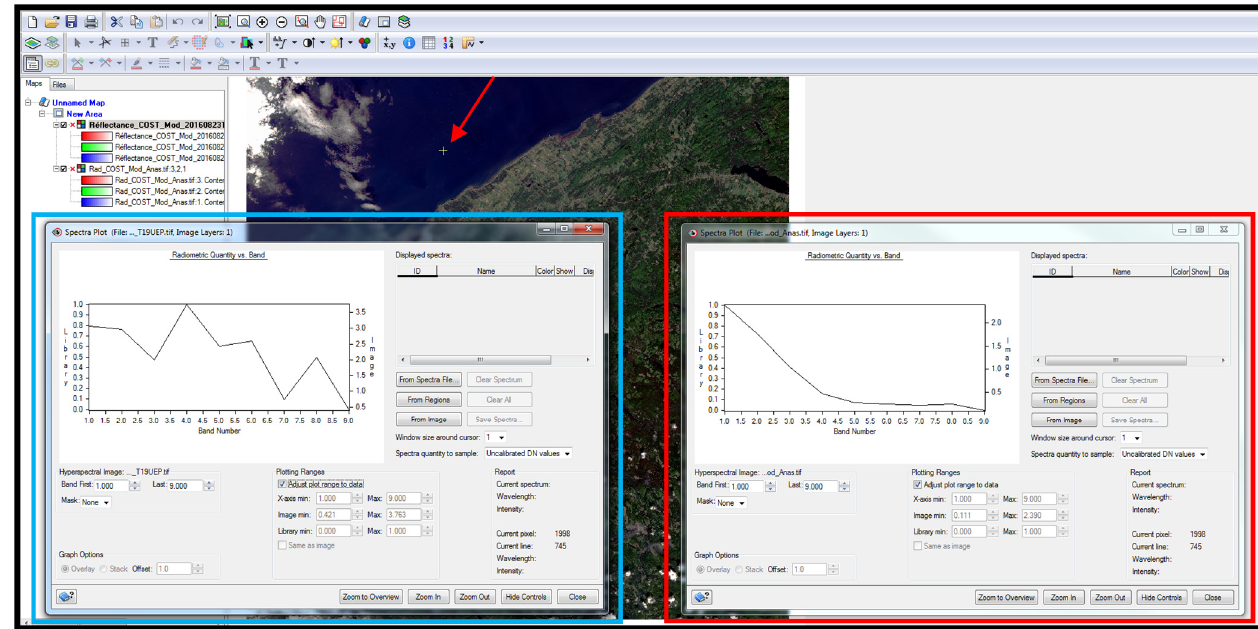
Figure 11. Comparison of spectral reflectance of Sentinel-2 bands picked up over a water pixel (yellow star) using: the modified version of COST blue band radiance-based (blue frame) and the modified version of COST all bands radiance-based (red frame).